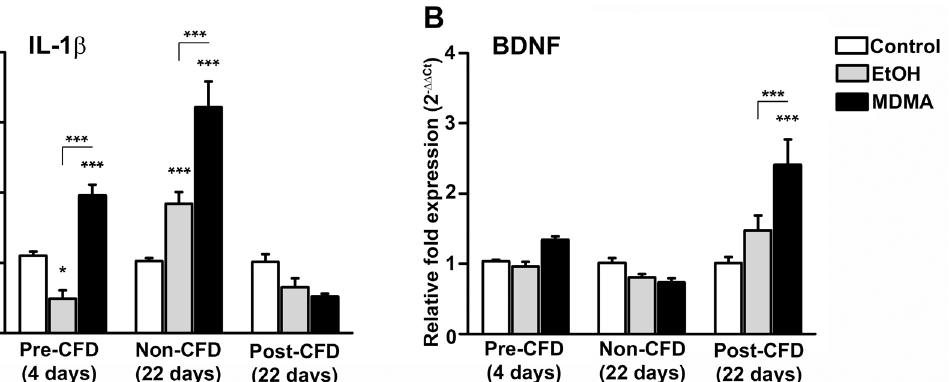
Fig 3. Altered IL-1 β and BDNF mRNA expression following drug consumption and contextual fear discrimination. Samples were collected from the hippocampus of sacrificed animals: pre-CFD (4 days after drug consumption and 12h after behavioral studies), non-CFD (22 days after drug consumption) and post-CFD (4h after completing the CFD task and 22 days after drug consumption). Relative ( A ) IL-1 β and ( B ) BDNF mRNA expression following drug consumption reveal alterations related both to drug and behavioral testing. Data shown are the mean ± SEM (n = 4 – 8 mice/group). Statistically significant differences between groups are represented by * ( p < 0.05) and *** ( p < 0.001; Bonferroni ’ s post hoc test). BDNF, brain-derived neurotrophic factor; IL-1 β , interleukin-1beta; MDMA,